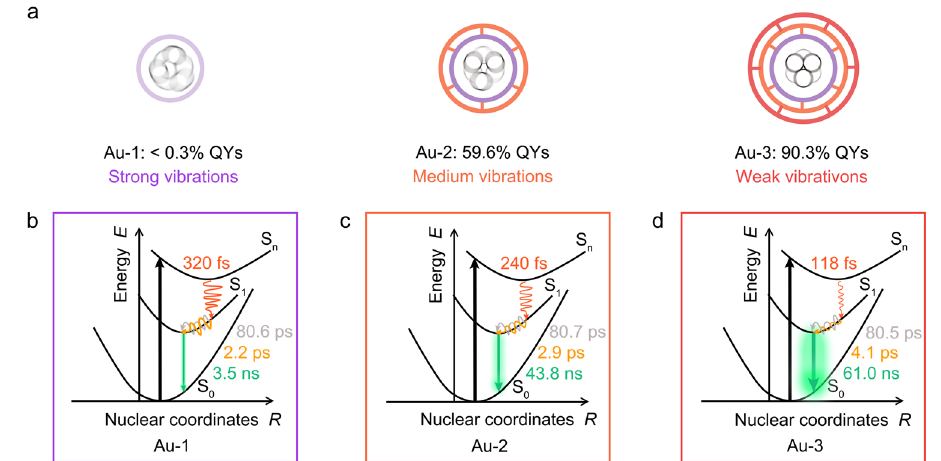
Fig. 5 | Schematic illustration of the excited-state electron dynamics and coherent vibrations of Au-1, Au-2, and Au-3 NCs. a Schematic illustration of coherent vibrations and corresponding QYs of Au-1, Au-2, and Au-3 NCs. The pur- ple, orange, and red circles stand for layer-by-layer coating of ATT, ARG, and TOA ligands, and the black circles refer to the central gold atoms in three Au NCs. The energyplotsshowtheexcited-stateelectrondynamicsof( b )Au-1,( c )Au-2,and( d )